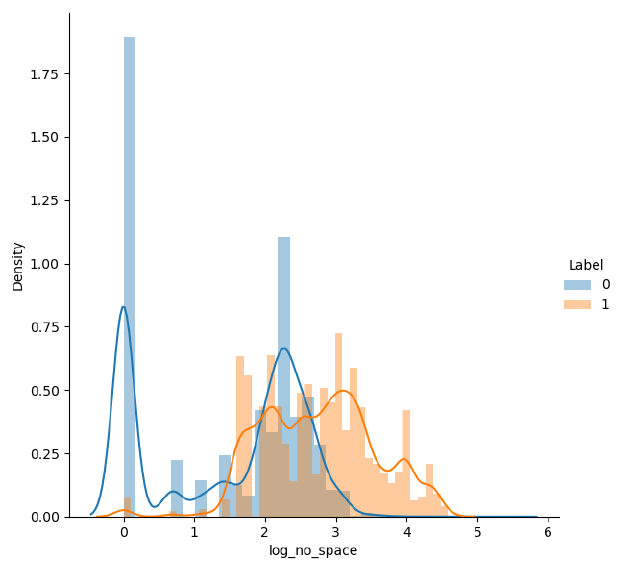
Figure 11. Log-transformed distribution of feature 8. The horizontal coordinate indicates the loga- rithm of the number of spaces in the SQL query, and the vertical coordinate indicates the correspond- ing probability density function. The blue line indicates benign samples and the orange line indicates malicious samples. As can be seen, this distribution is not a perfect Gaussian distribution and there is a lot of overlap between the two categories.